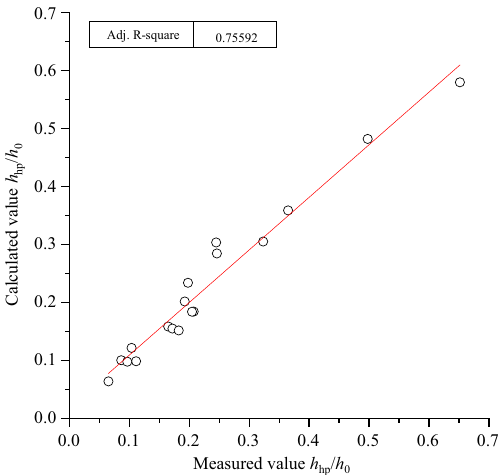
Fig. 6 Relationship between maximum wave height of landslide- induced surges and initial water depth